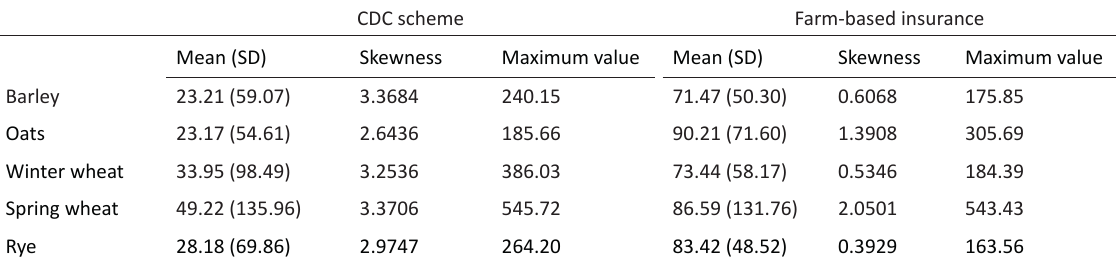
Table 5. Distribution of historical annual hectares lost (total and partial lost hectares per 1000 cultivated ha) in the CDC scheme and estimated annual hectares lost (hectares where losses exceed the 30% deductible level per 1000 cultivated ha) under the farm-based insurance